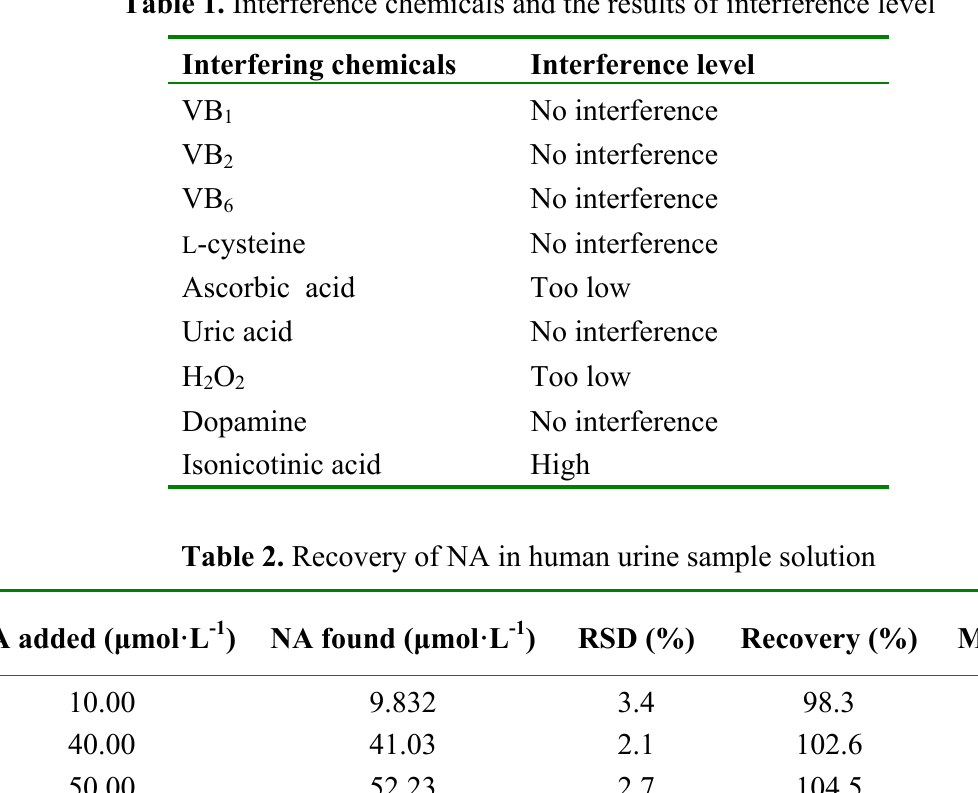
Table 1. Interference chemicals and the results of interference level